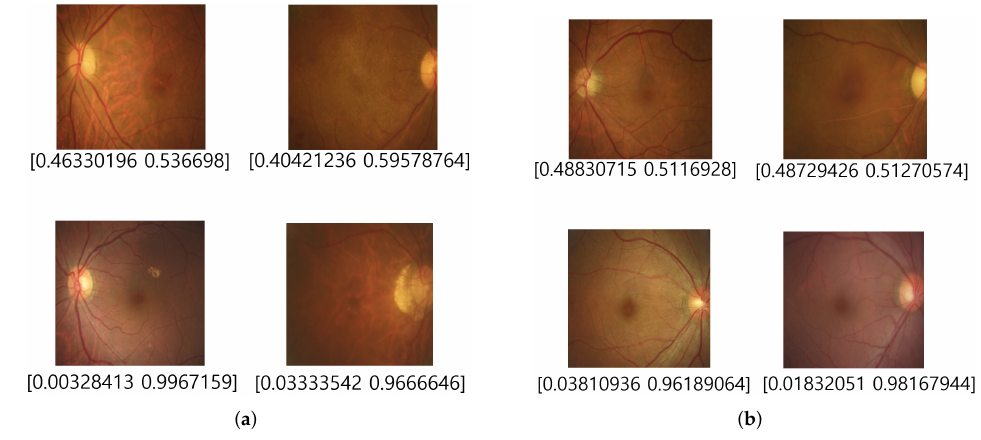
Figure 15. Examples of misclassification of Class A and the probabilities of Softmax: The pair of numbers in parenthesis are the probability values from Softmax. The first value is the probability that the image is in Class A and the second value is the probability that the image is in Class B. ( a ) Class 1 of Class A; ( b ) Class 2 of Class